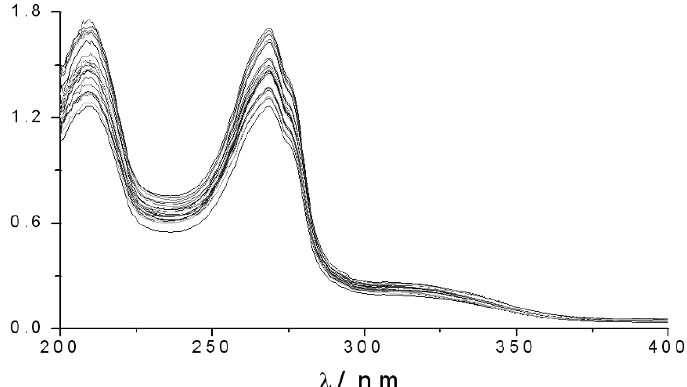
Figure 3. UV spectra obtained from 3 4 Box-Behnken